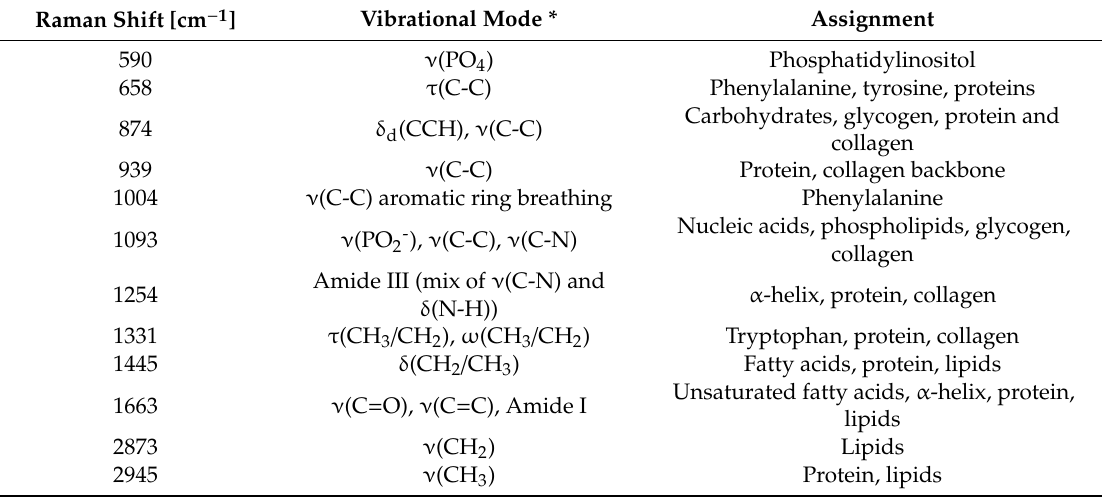
Figure 2. First principal component calculated via PCA with labelled Raman bands. Table 1. Raman band assignments of vibrational modes at significant Raman peaks determined by the first principal component derived from